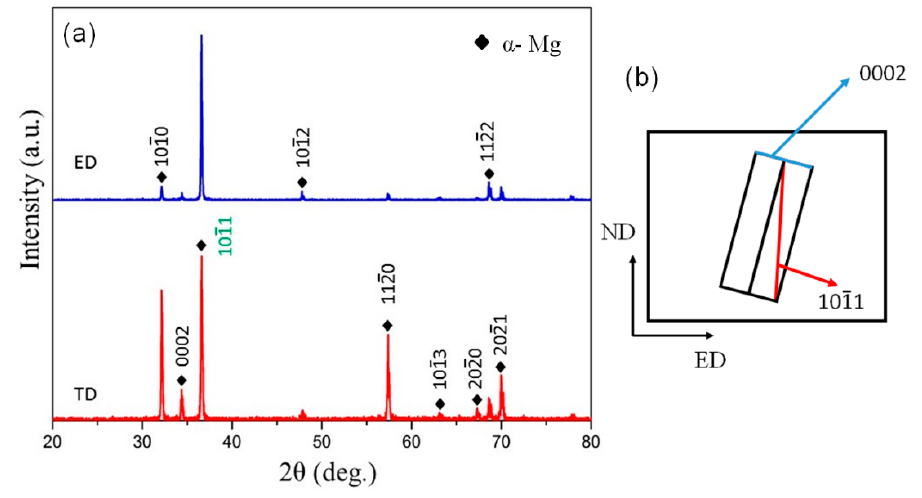
direction of XK105-H; F-ED: extrusion of XK105-F; F-TD: transverse of XK105-F).